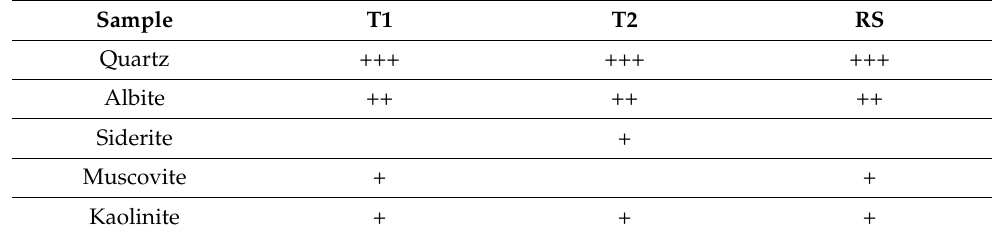
Table 3. Mineral composition of used rock and RS